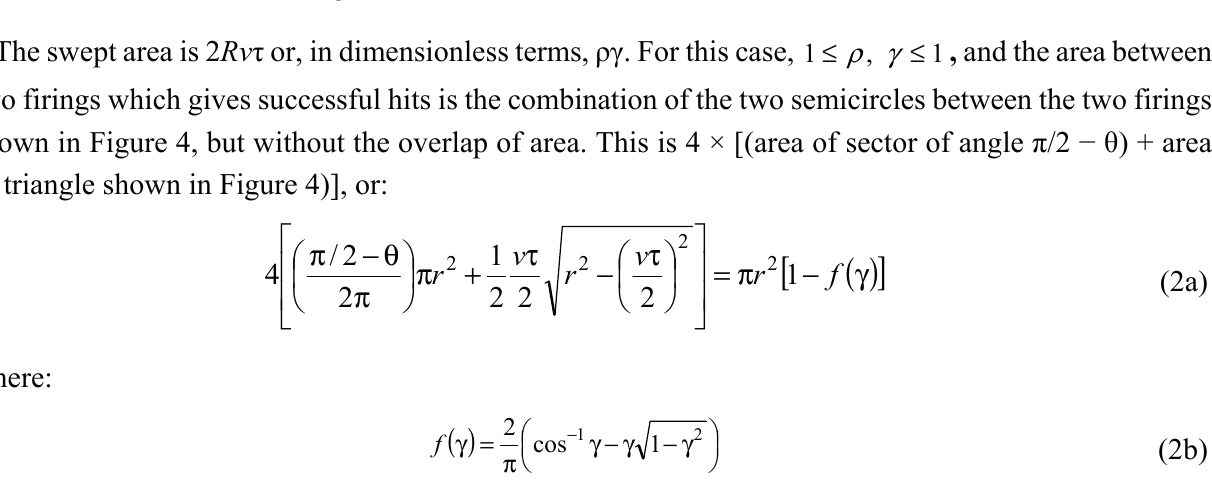
Figure 4. The circular areas within which target centers lie for successful hits, for two successive actuator